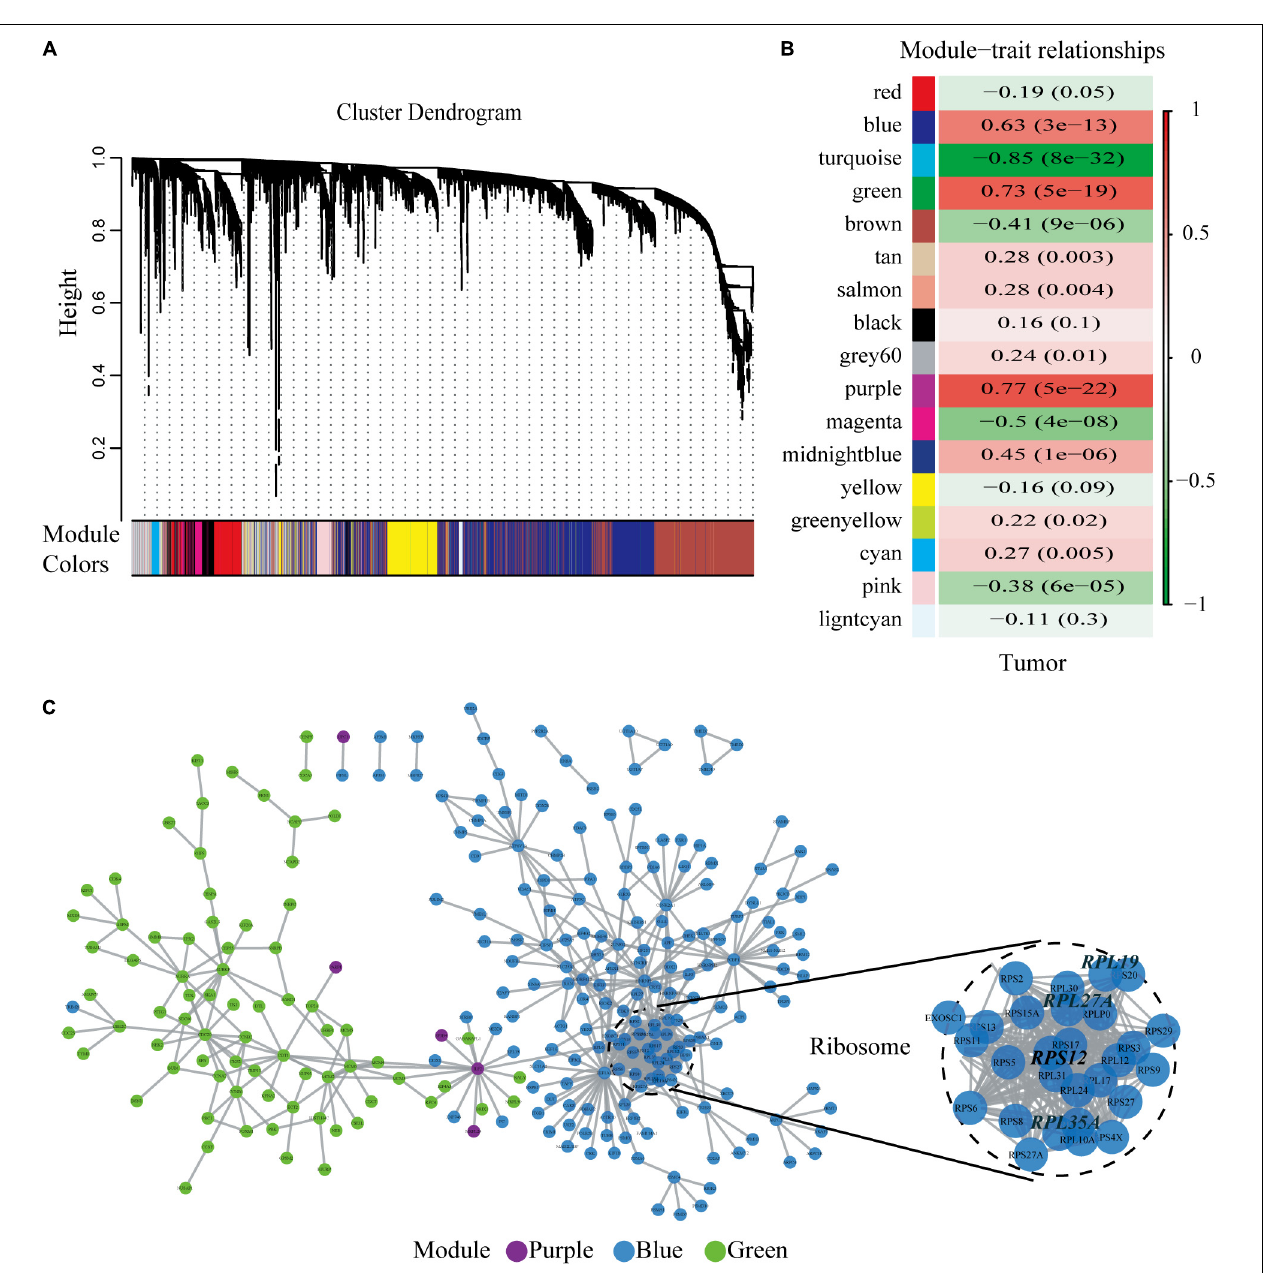
FIGURE 3 | Selected hub modules and the human PPI network. (A) Gene dendrogram and module colors. (B) Relationship between modules and traits. The figure showed the correlation coefficients and the P -values. Red meant positive correlation, while green meant negative correlation. (C) Human PPI network was conducted based on the three hub modules. PPI, protein–protein